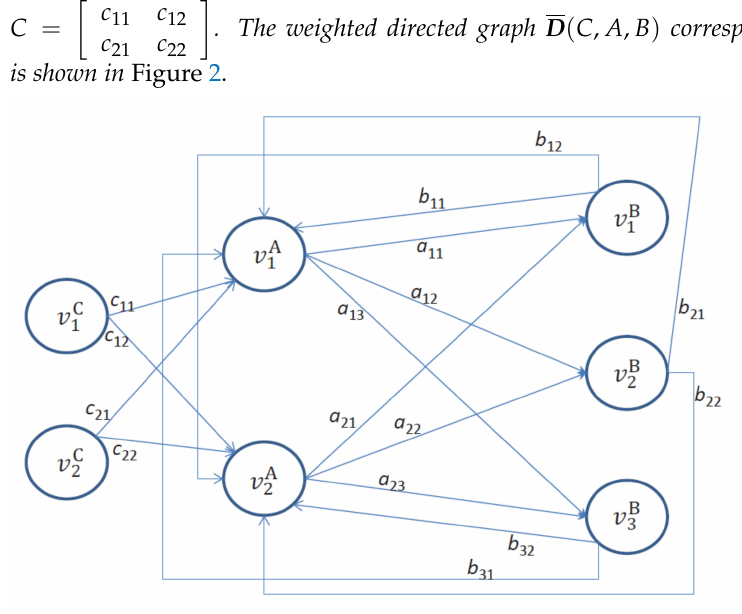
Figure 2. The weighted directed graph D ( C , A , B ) for Example